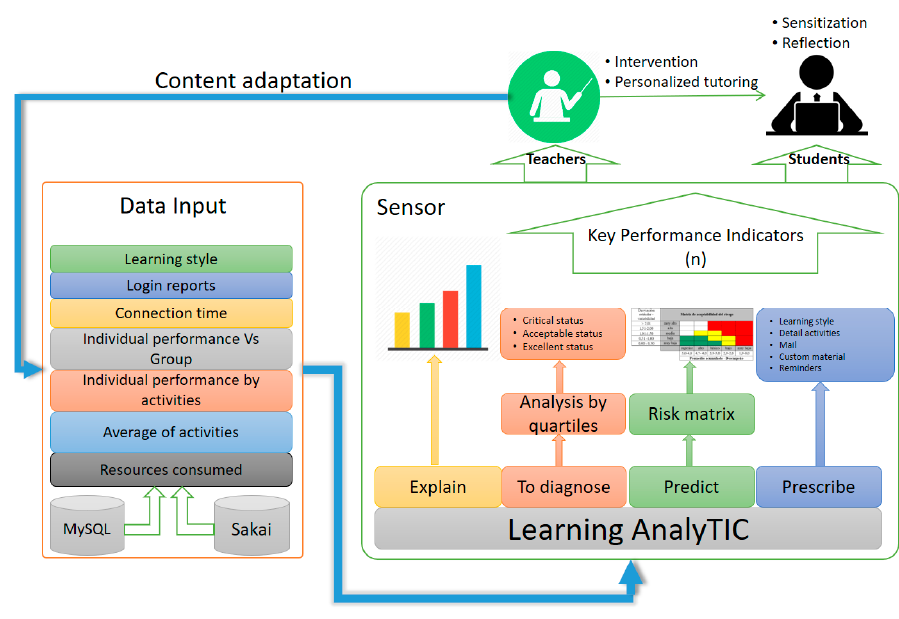
Figure 2. Logical design of the sensor.